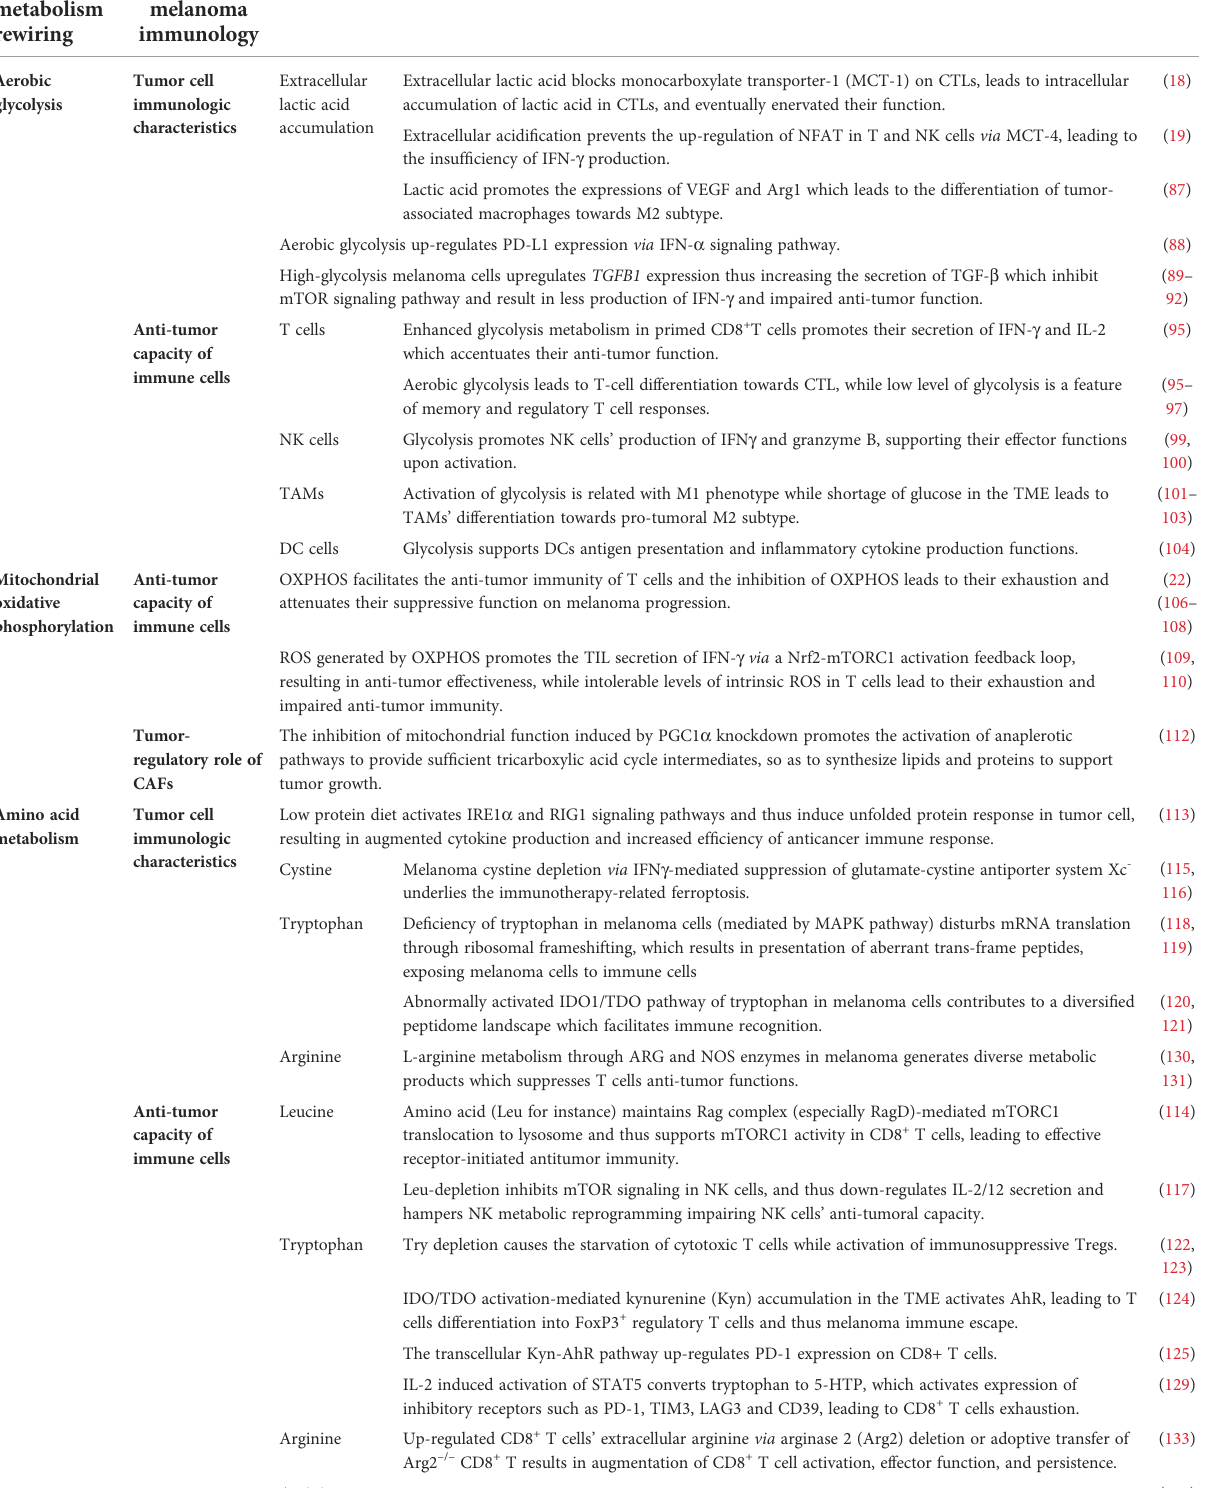
TABLE 1 The crosstalk between metabolism rewiring and melanoma